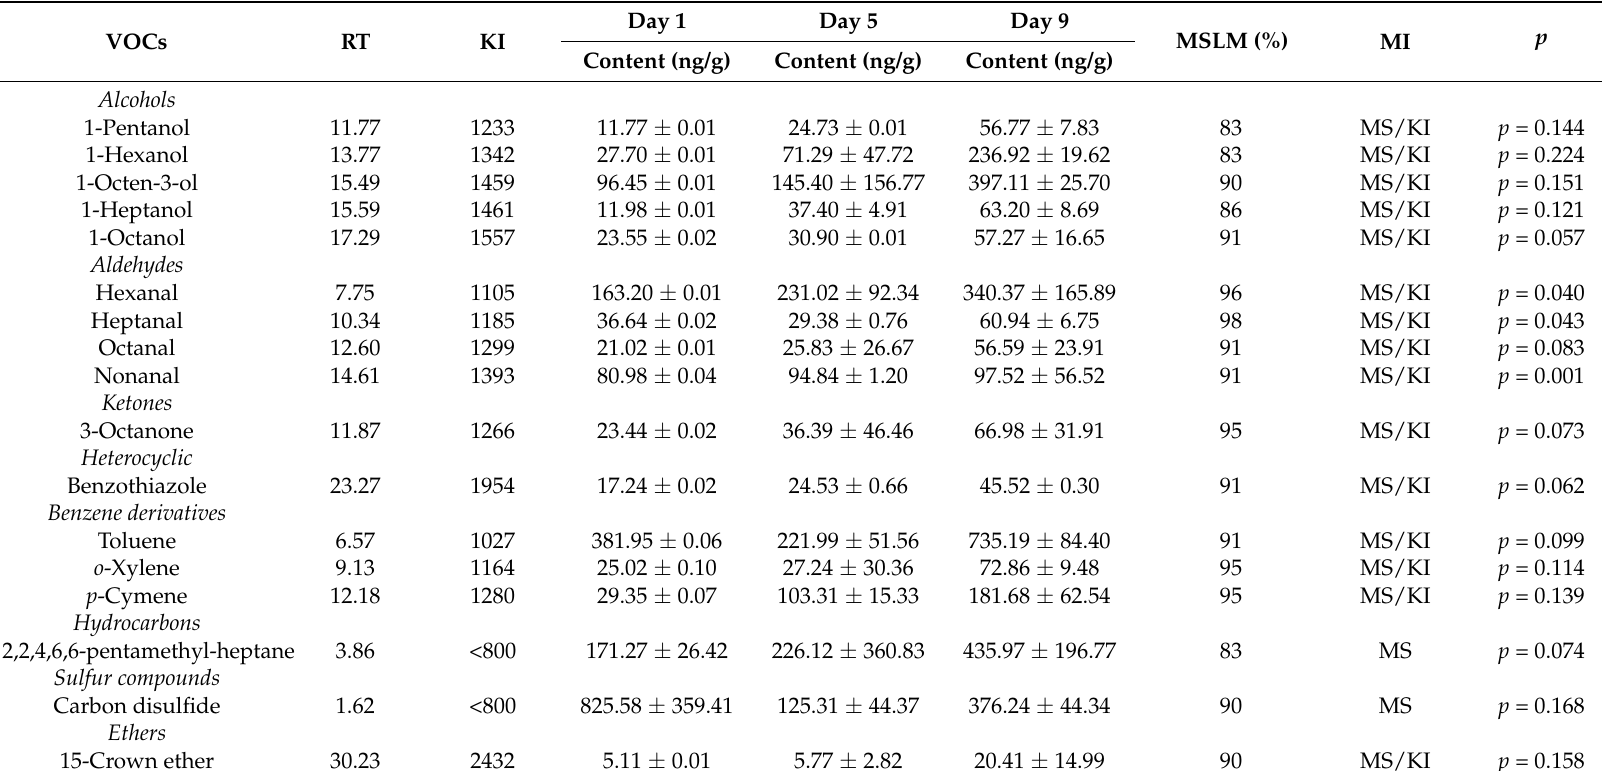
Table 1. Volatile compounds (average ± SD, ng/g) determined in raw lamb meat under air packaging with respect to storage time (days). Day VOCs RT KI